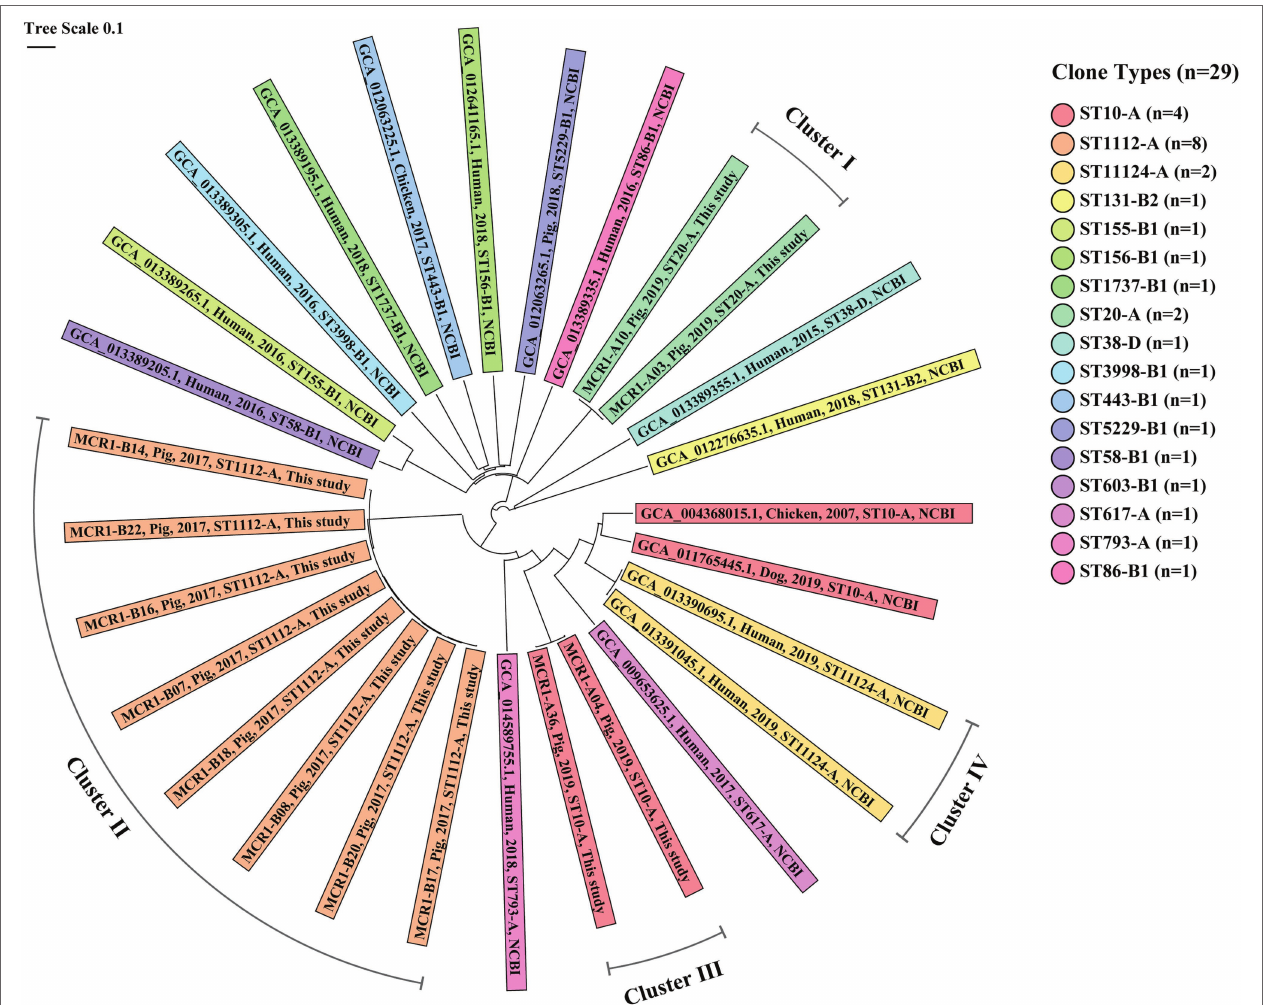
FIGURE 7 | Core genome MLST (cgMLST)-based genetic relatedness between 29 MCR1-EC isolates from South Korea. Data comprise 12 intestinal pathogenic MCR1-EC strains isolated in this study and 17 MCR1-EC strains isolated from South Korea, published in the National Center for Biotechnology Information (NCBI) GenBank database. The phylogenetic tree based on cgMLST was constructed using the neighbor-joining algorithm with default parameters implemented in the Ridom SeqSphere+ program (v8.2.0). The color of shades corresponds to each clone type. The contents of shades include, from left to right, the assembly accession number, host, isolation date, clone type, and data source (this study or NCBI database) for each strain. Four clusters consist of MCR1-EC strains with a relatedness distance value less than 0.01. MCR1-EC, Escherichia coli carrying the mobilized colistin resistance gene mcr-1.1 ; MLST, multi-locus sequence